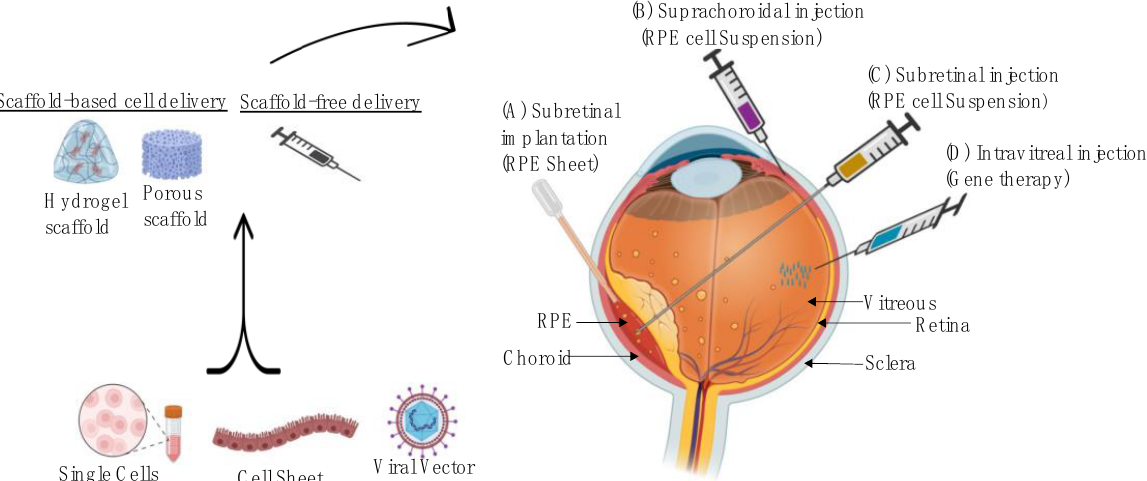
Figure 1. Overview of scaffold fabrication and the delivery methods of cells-based and gene-based approaches for the retinal degeneration disease. ( A ) Subretinal implantations, performed in the operating room, allows for direct delivery of RPE sheet as a cell suspension into the subretinal space, ( B ) Suprachoroidal injection is a nonsurgical method to deliver therapeutic suspension into a virtual space between the sclera and choroid, ( C ) Subretinal injection delivers RPE cell suspension under the sensory retina using a micro-needle and ( D ) Intravitreal injection method is applied in an office setting to deliver vectors to the vitreous cavity.